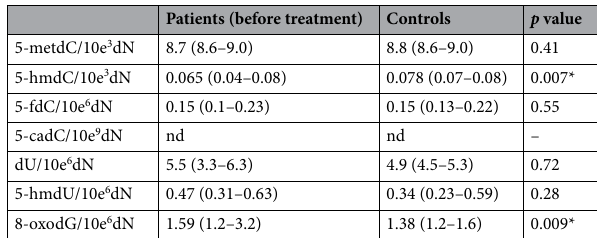
Table 2. The levels of active demethylation products of 5-methylcytosine and 8-oxodG in leukocyte DNA. The results are presented as median values with interquartile ranges ( * p < 0.05).